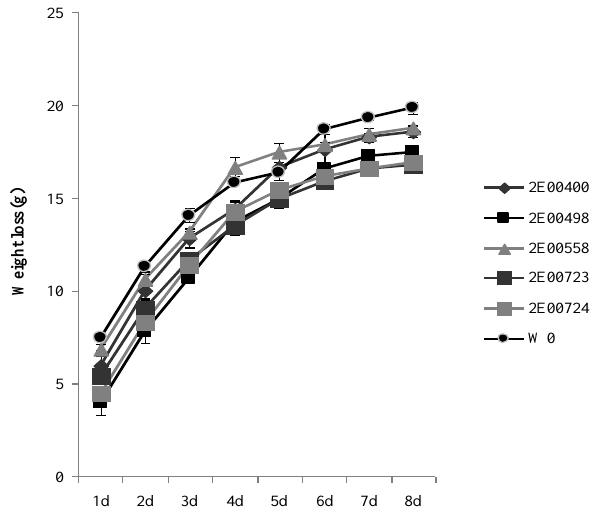
Figure 2. CO 2 liberation by fermentation of different yeast strains grown in the synthetic media containing 200.0 g L − 1 sucrose. Data are given as means ± SD, n = 3. All the experiments were done in triplicate, with the results averaged for each experiment.